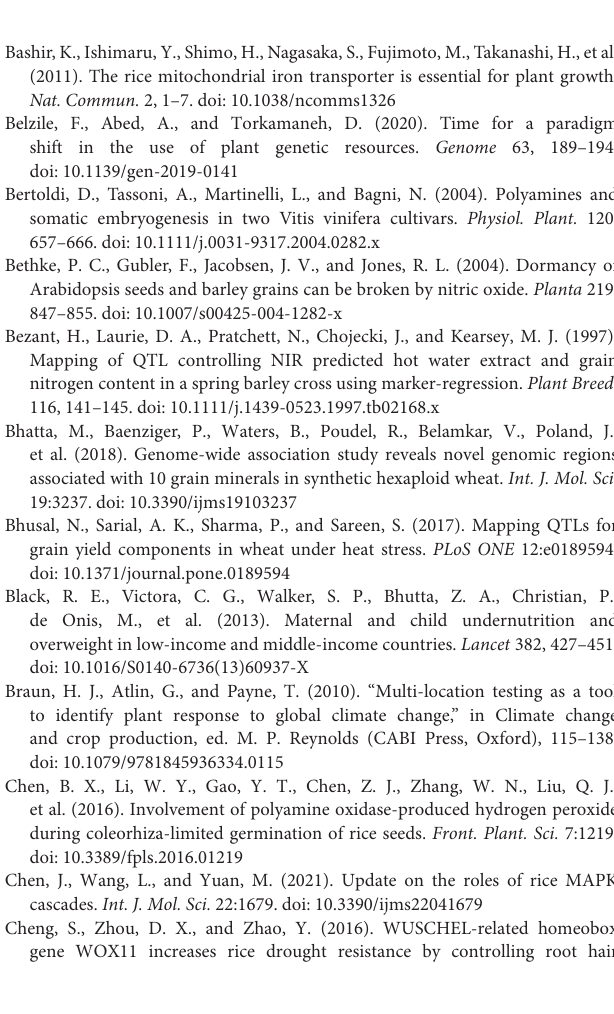
Supplementary Table 5 | The list of rice orthologous genes at each MQTL interval. Supplementary Table 6 | The information of the chi-square test for co-localization frequency analysis of the QTLs of the tested traits in the detected MQTLs